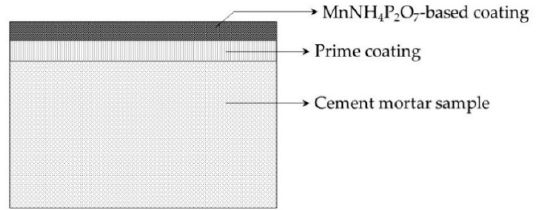
Figure 2. Cross section of the coatings on the surface.